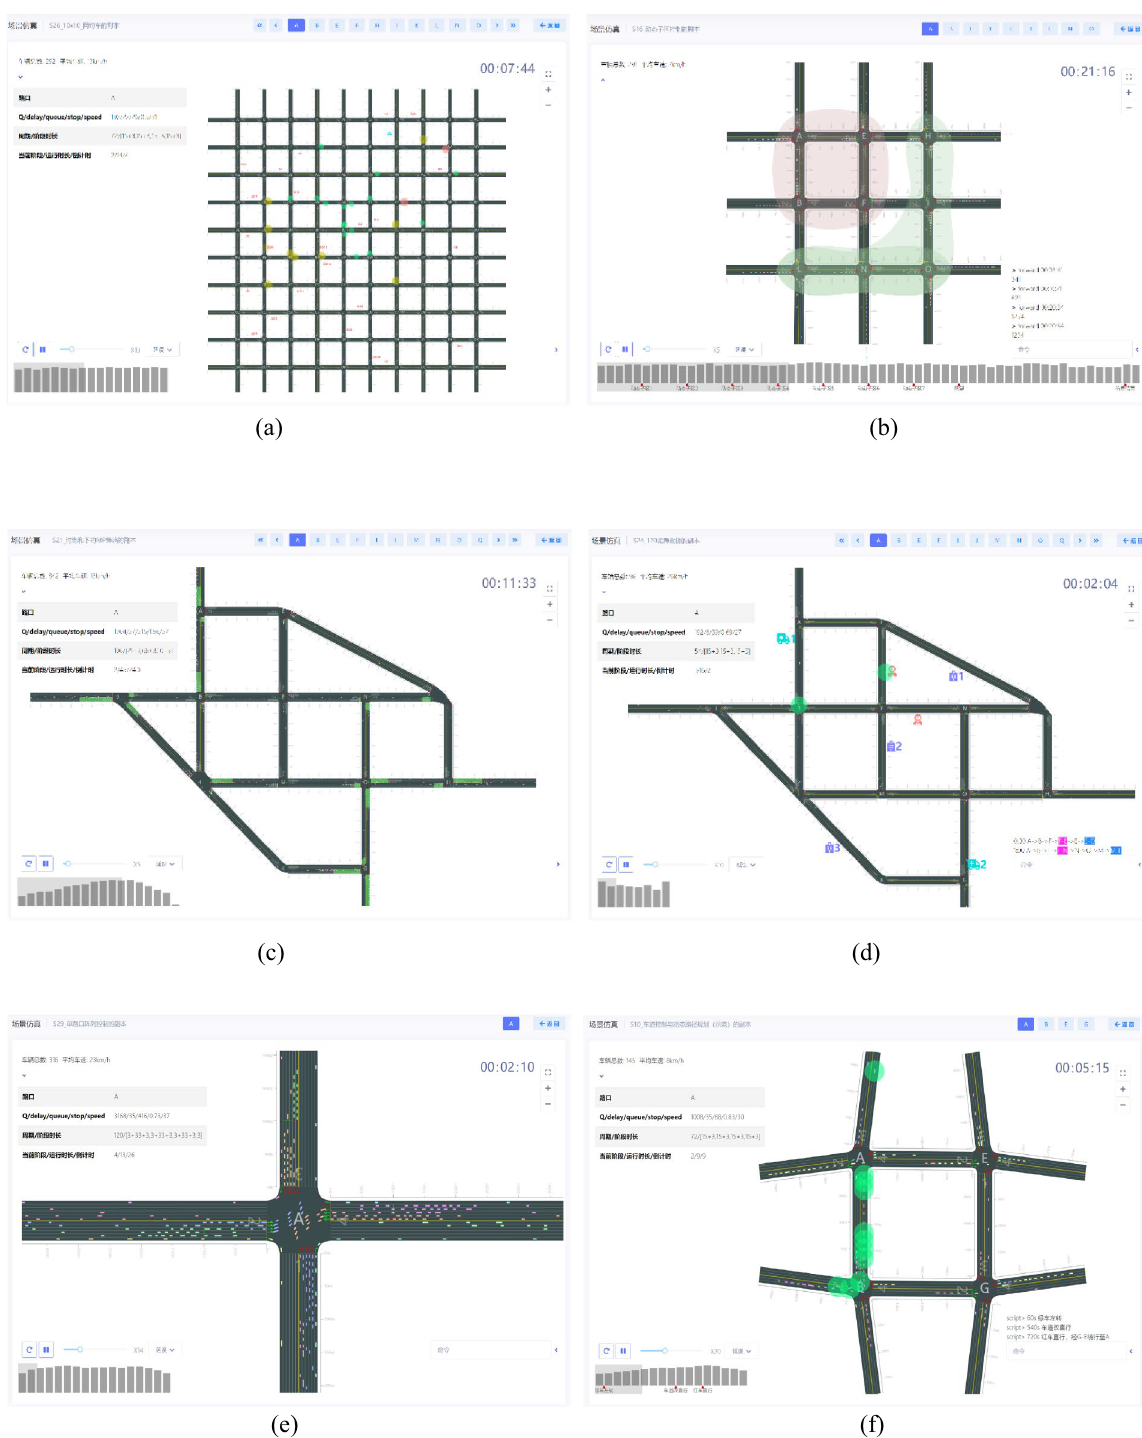
Figure 7. Some examples of the simulation integration platform. ( a ) Example of large-scale road network simulation, ( b ) Example of the dynamic subarea control simulation, ( c ) Example of supersaturation control simulation, ( d ) Example of emergency vehicle priority control simulation, ( e ) Example of queuing and array control, ( f ) Example of the dynamic lane and speed